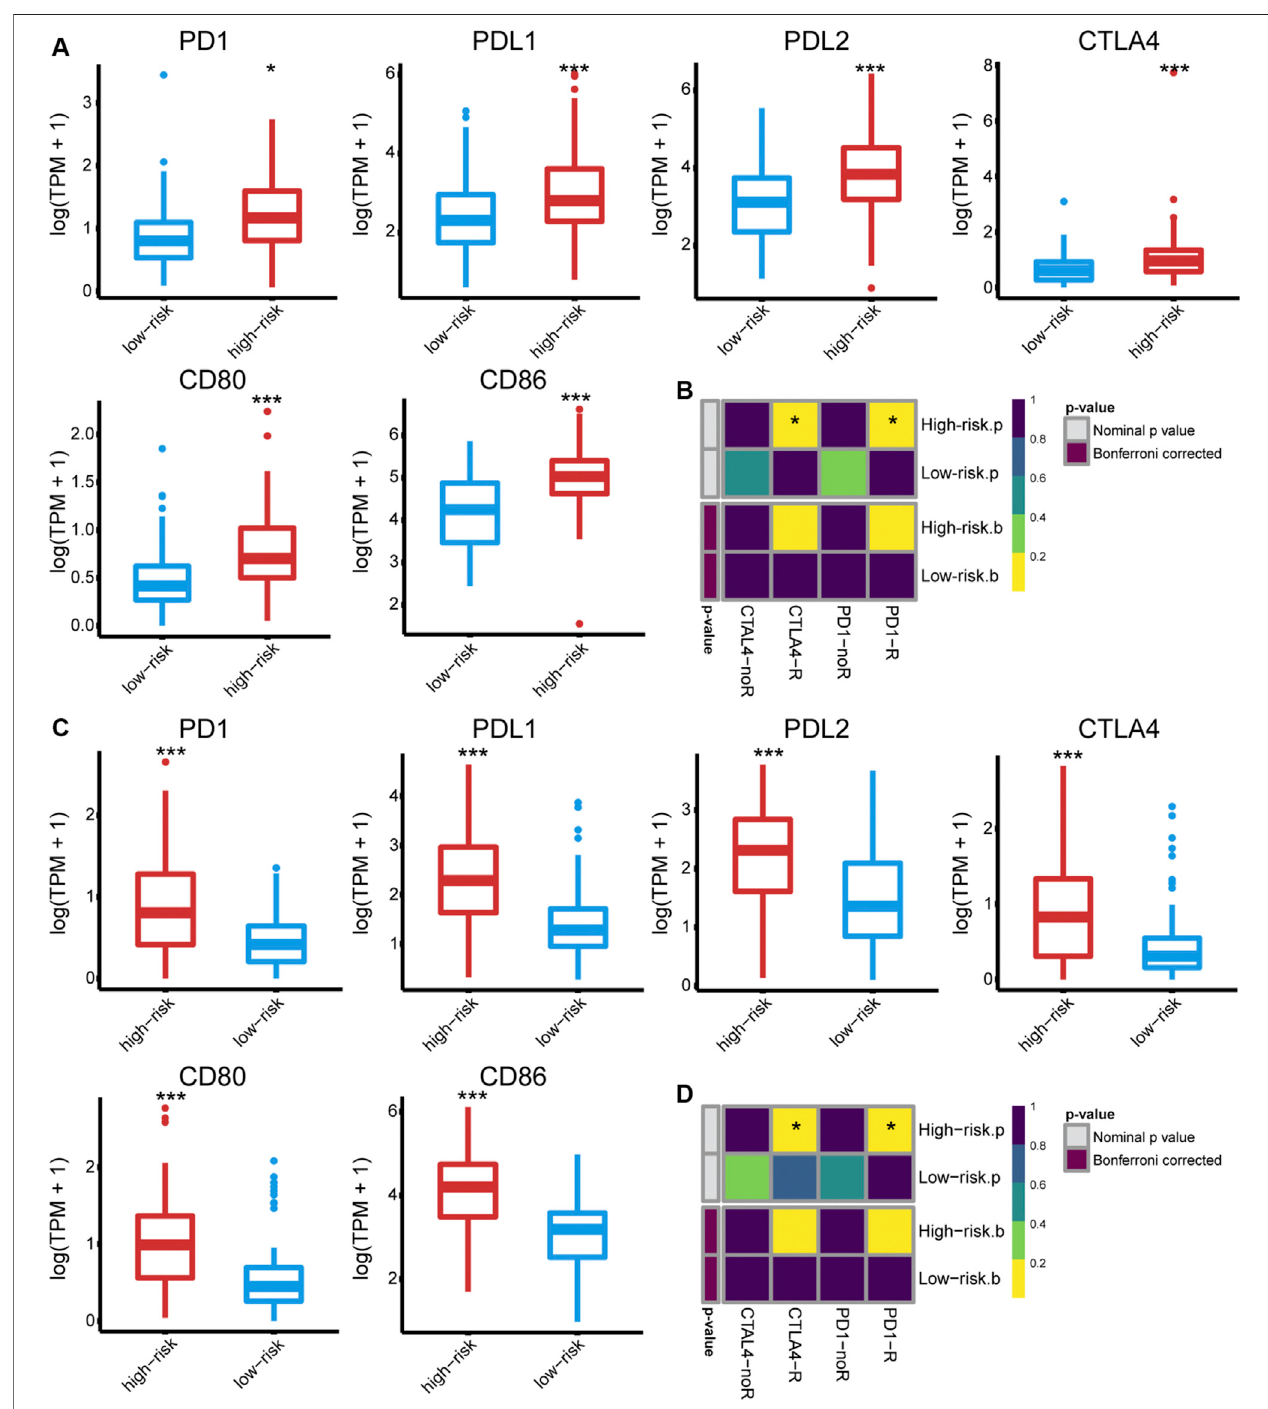
FIGURE 6| The expression ofPD1 and CTLA4, aswell astheir ligands (PD-L1, PD-L2, CD80, and CD86) in the (A) TCGA and (C) CGGA325 cohort, respectively. The predicted responsiveness to ICB therapy in the (B) TCGA and (D) CGGA325 cohort, respectively.